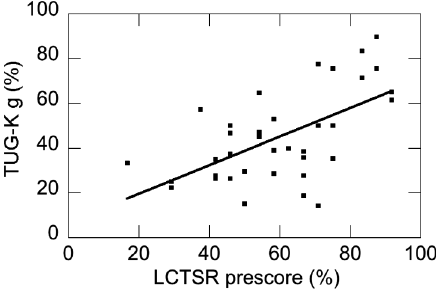
FIG. 3. Normalized learning gains on TUG-K versus LCTSR prescore. The solid line is the line of best fit (slope ¼ 0 : 64 and r ¼ 0 : 59 ).